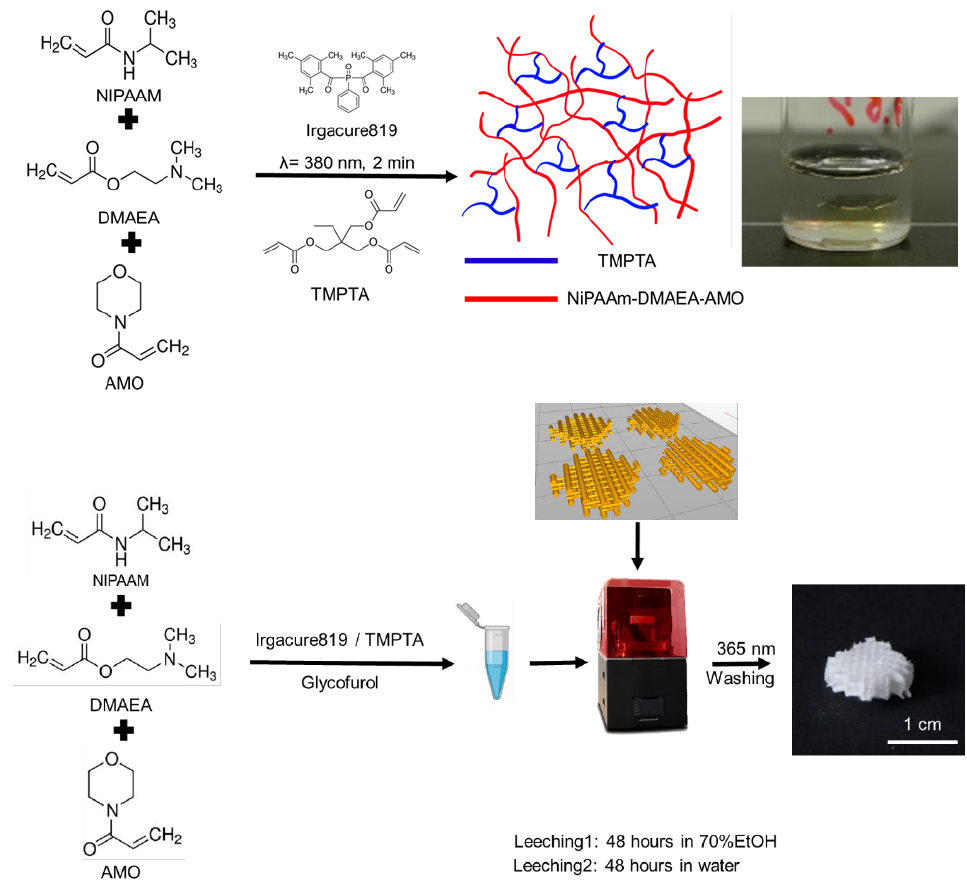
Figure 10. Stimuli-responsive fabrication of temperature-sensitive biomaterials by photo-induced bulk polymerization and cDLP printing. A monomer mixture with PI is irradiated with UV light to cross-link the resin in disc shape or as scaffold produced by cDLP. The cross-linked matrices were washed with aqueous ethanol (70% (V/V)) and water.